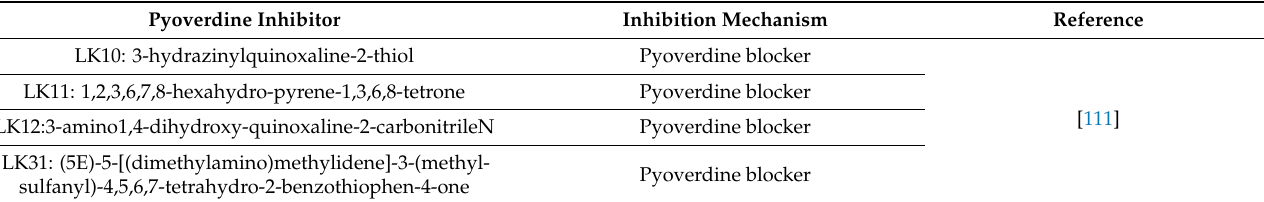
Table 2. List of pyoverdine inhibitors and related